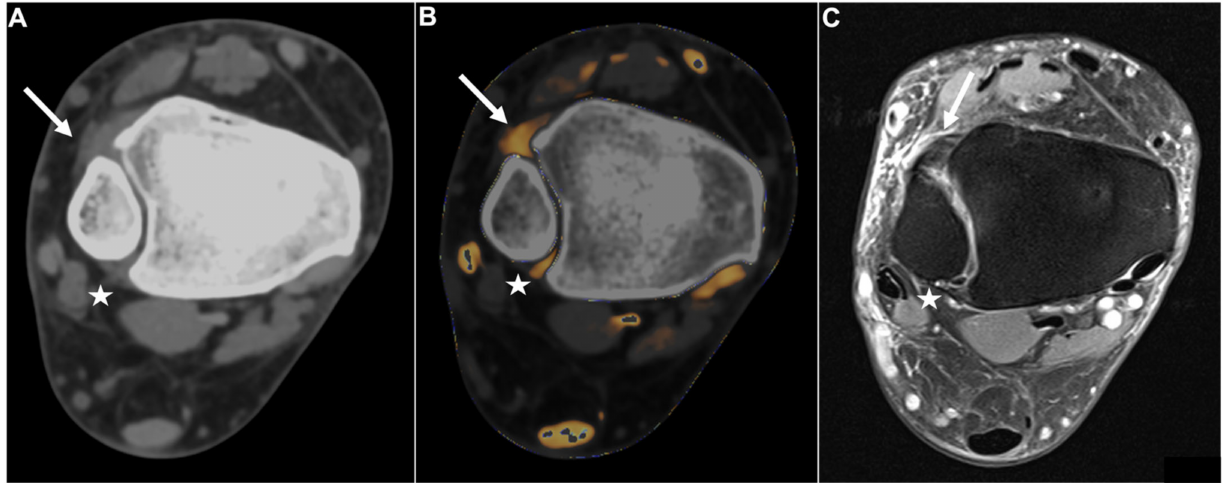
Figure 2. Intact DTFS. Standard axial unenhanced grayscale CT ( A ), color-coded collagen reconstructions ( B ), and proton density-weighted unenhanced MRI series with fat saturation ( C ) of a patient with an ankle sprain. No diagnostic assessment of the DTFS is possible in the grayscale images. After collagen mapping, the ATIFL ( arrow ) and PTIFL ( star ) demonstrate strong collagen signals, indicating that they are not injured. MRI confirmed the integrity of both ligaments. Abbreviations: DTFS, distal tibiofibular syndesmosis. ATIFL, anterior tibiofibular ligament. PTIFL, posterior tibiofibular